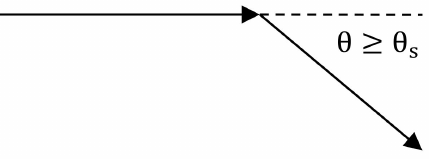
Figure 1. Angular value, or the change in travel direction, in degree between two traveling arcs.